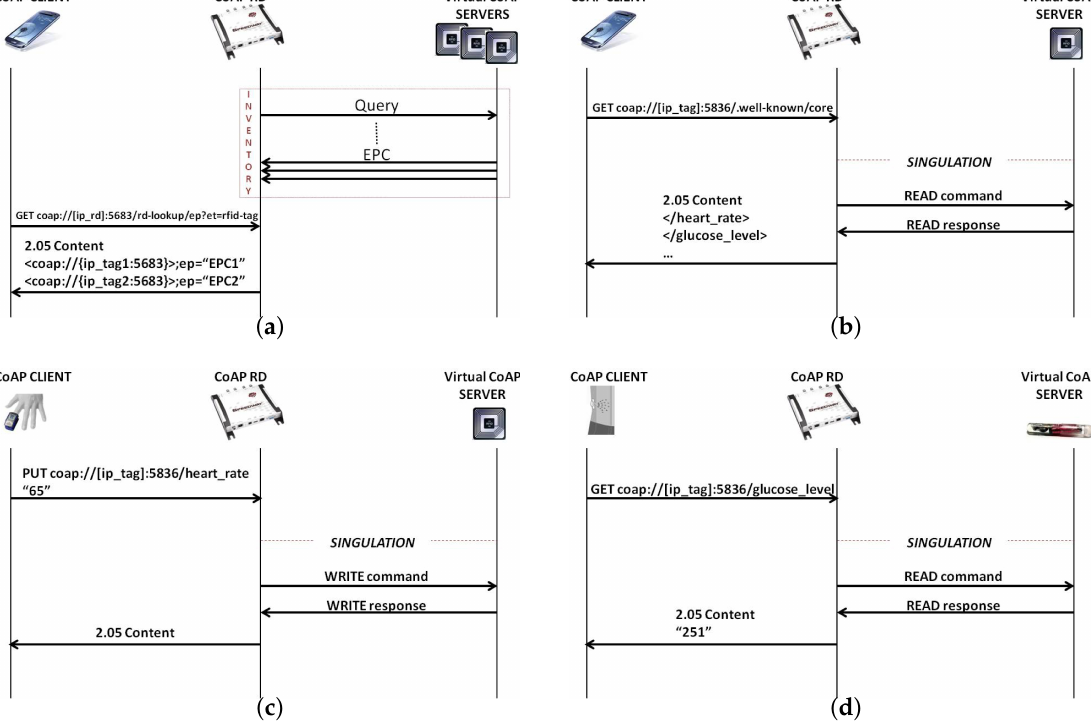
Figure 4. Message exchange. ( a ) Service discovery; ( b ) resource discovery; ( c ) sensor to tag communication; and ( d ) actuator to sensor tag